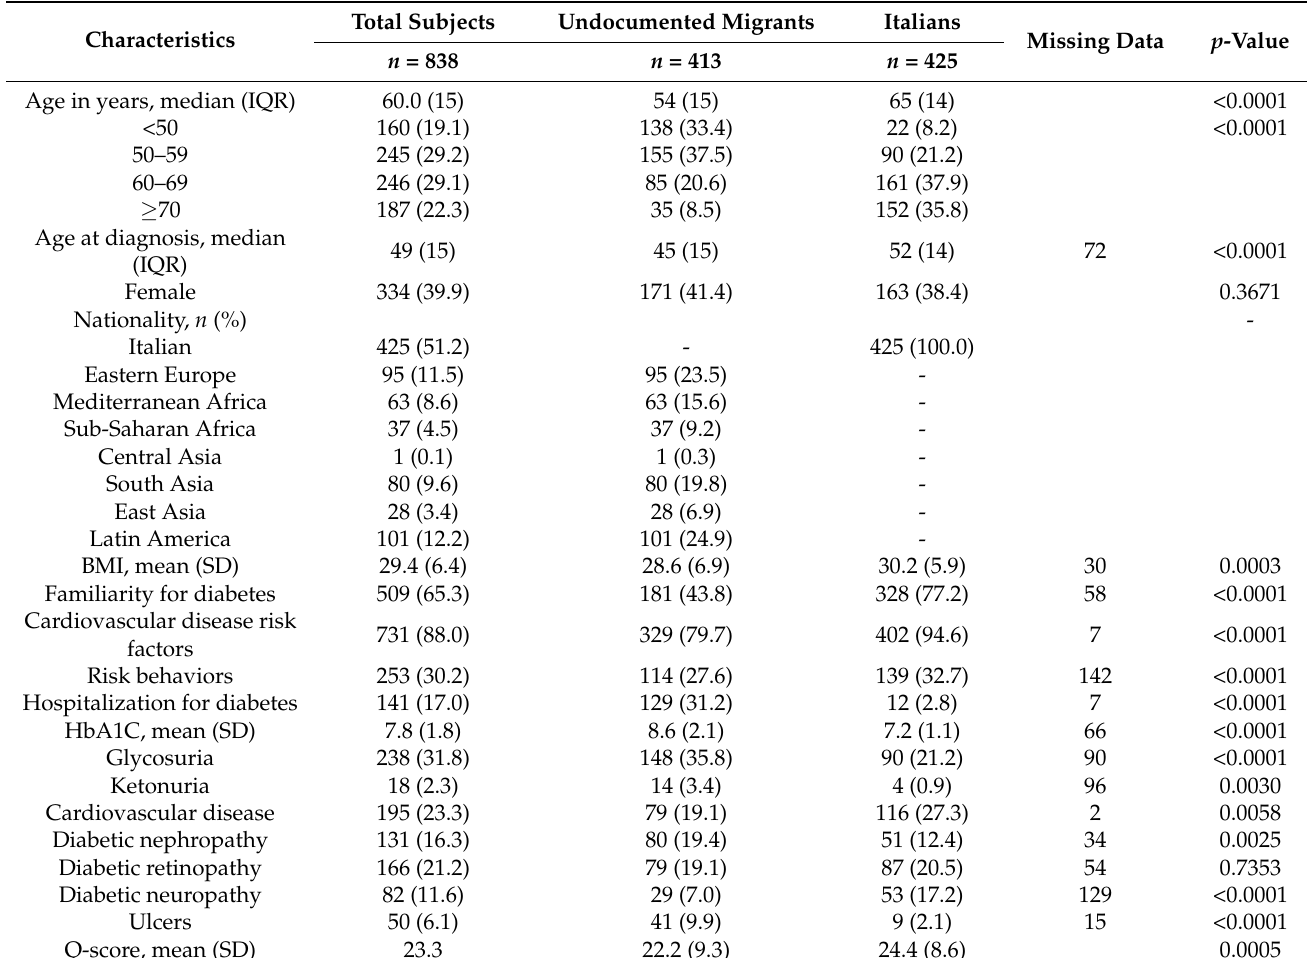
Table 1. Characteristics of 838 diabetic subjects included in the study.